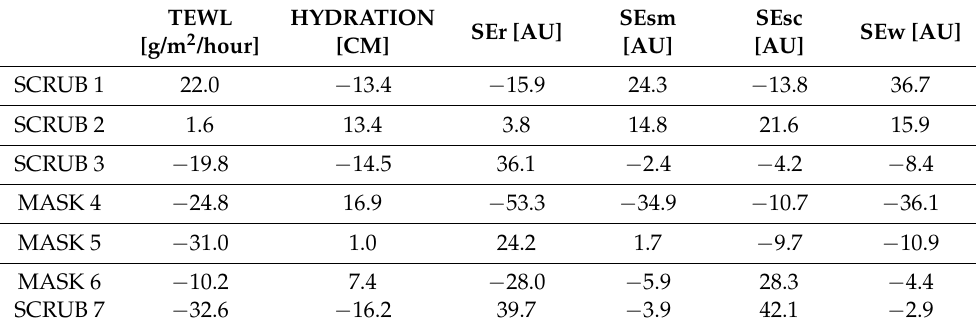
Table 2. Changes in the basic skin parameters (skin hydration and TEWL levels) and skin topog- raphy parameters determined for cosmetic products 1–7 in application tests (data are expressed as percentage change ∆ % ± 0.5%). TEWL [g/m 2 /hour]